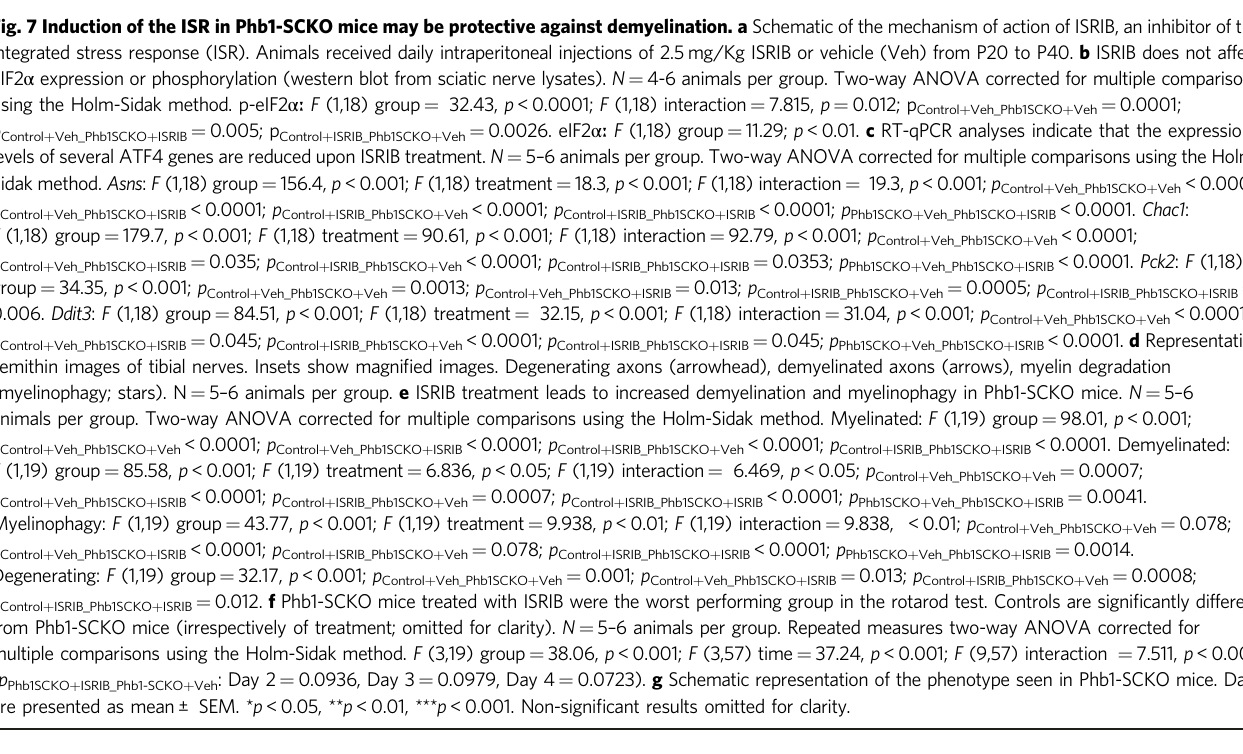
Fig. 7 Induction of the ISR in Phb1-SCKO mice may be protective against demyelination. a Schematic of the mechanism of action of ISRIB, an inhibitor of